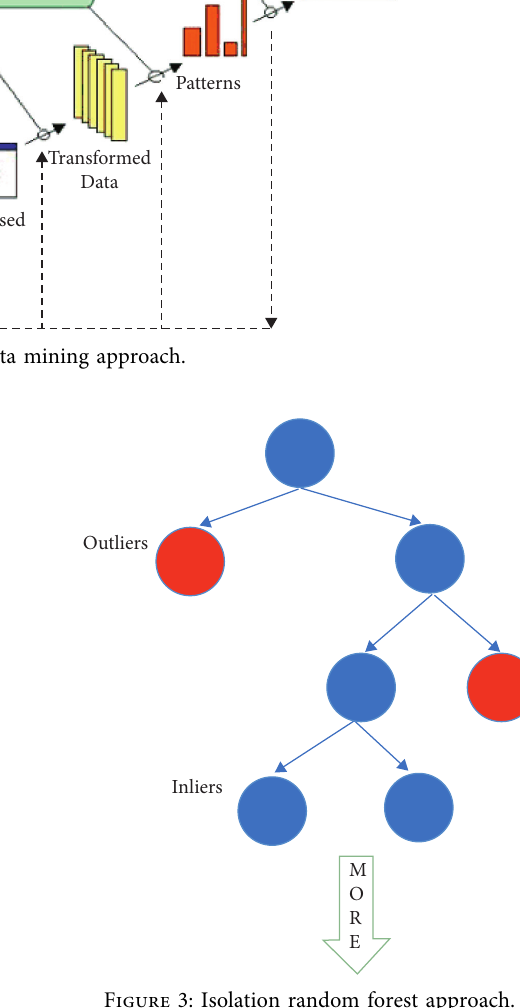
Figure 3: Isolation random forest